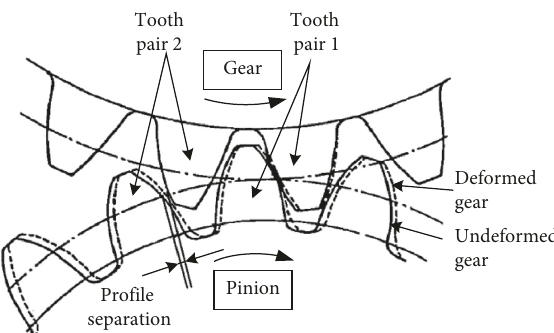
Figure 10: Deflection of the meshing tooth pair at the meshing position in contact zone